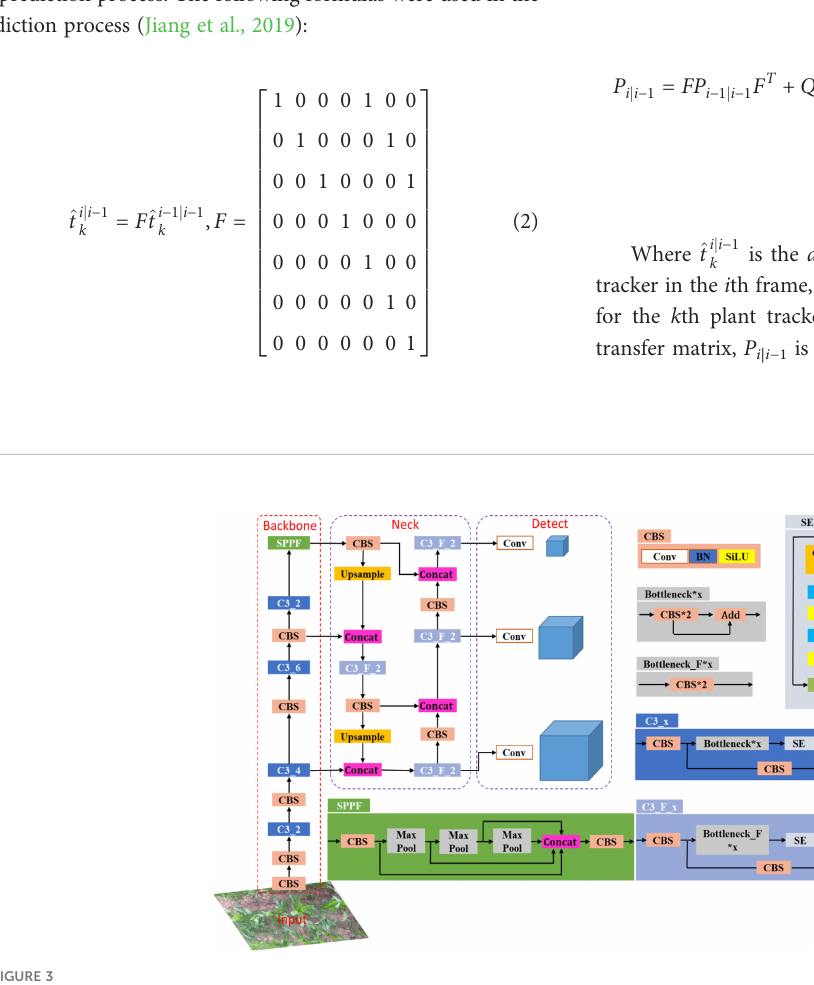
FIGURE 3 The structure of improved SE-YOLOV5m model. CBS contains a Conv, a BN and a SiLU (sigmoid liner relu) activation function, where Conv is 2D Convolutional layer, BN indicates batch normalization. C3_x indicates the use of a CBS structure with X residual modules (ResUnit), e.g. in the fi rst C3_x, one residual components are used, hence C3_1. C3_F_X has the same meaning as